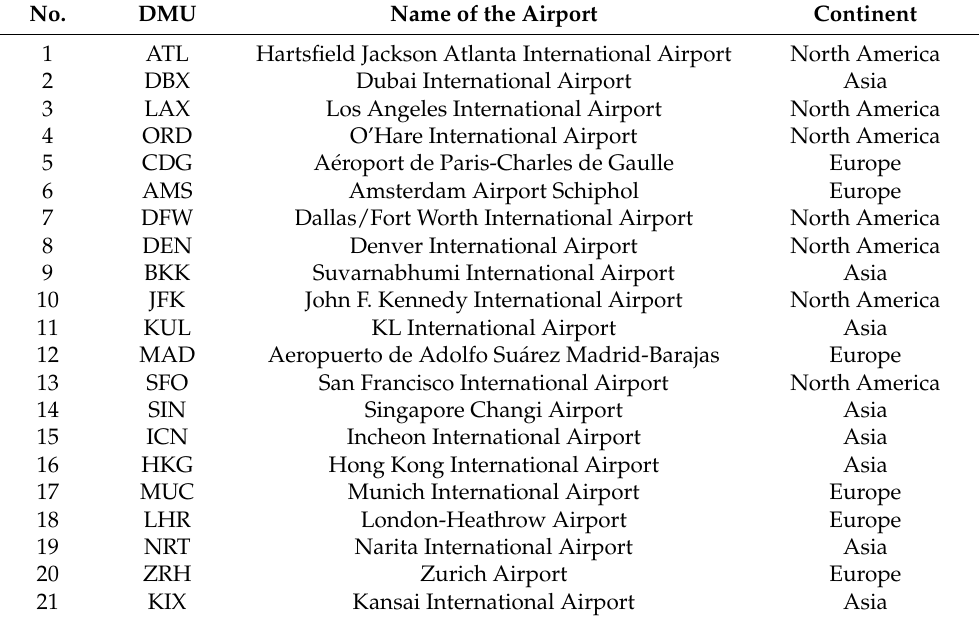
Table 2. The top 21 major airports in 2019 listed by ICAO.